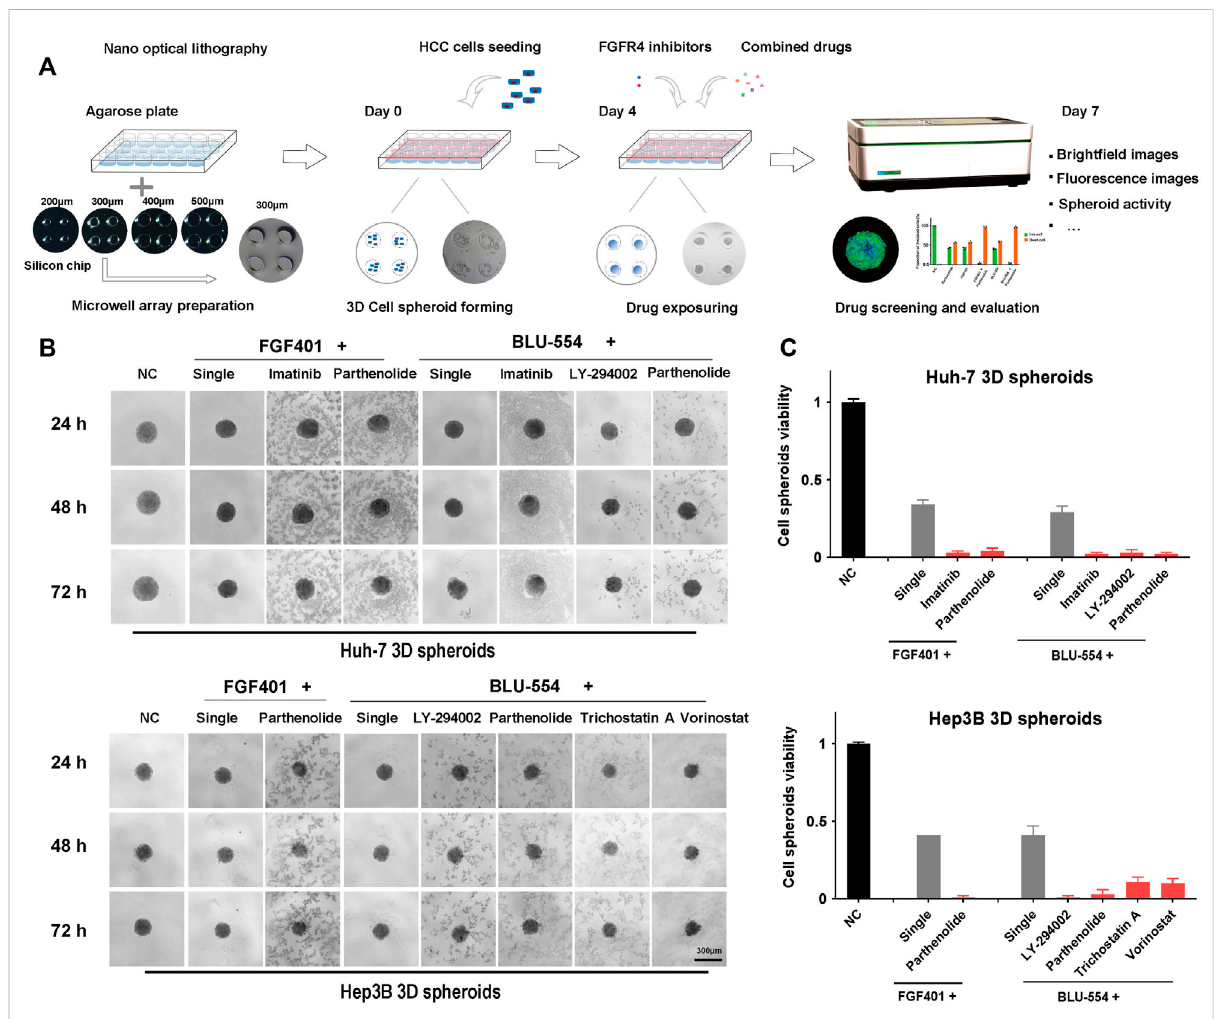
FIGURE 5 3D cell spheroids to evaluate the effect of combined schemes. (A) Schematic diagram of agarose microwell plate fabrication and cell spheroid culture process. (B) The state of Huh-7 and Hep3B 3D cell spheroids using the combination drug schemes were photographed in the bright fi eld under the microscope. (C) The activity of Huh-7 and Hep3B 3D cell spheroids using the combination drug schemes was detected by the Resazurin